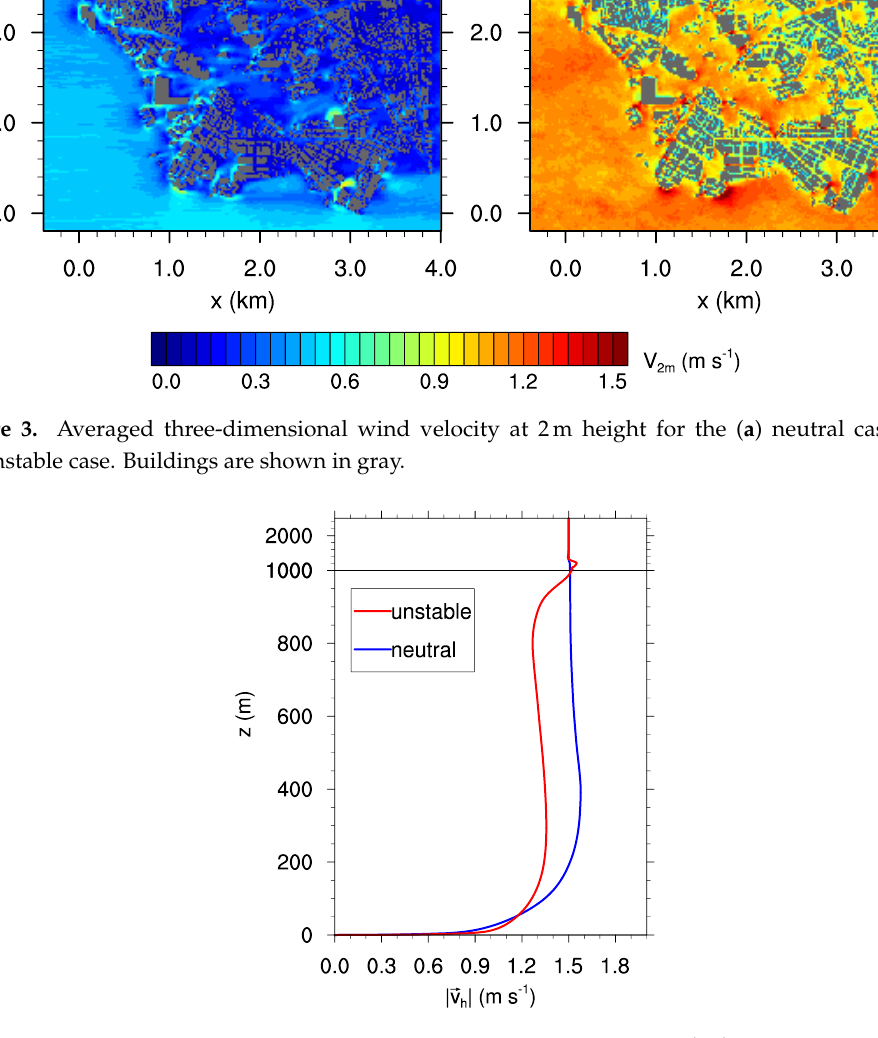
Figure 4. Vertical profile of the wind speed of the mean horizontal wind vector | (cid:126) v h | within the recycling